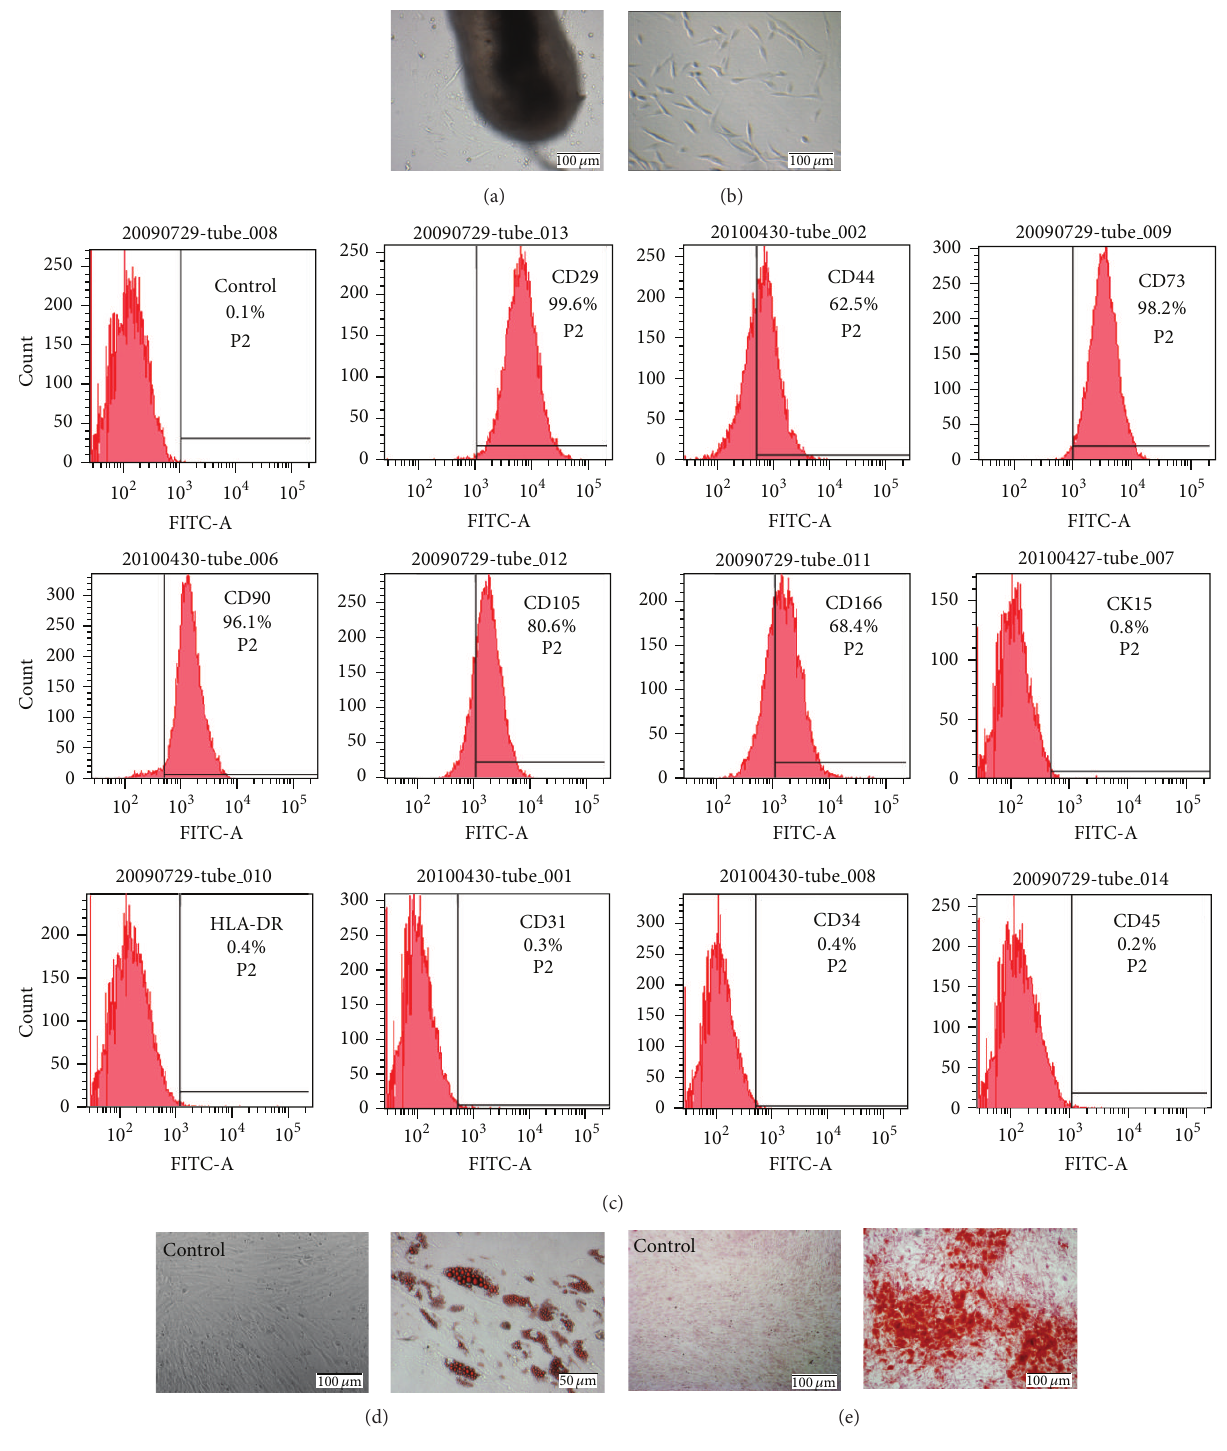
Figure 1: Isolation and characterization of hHFMSCs. (a) The hHFMSCs, resembling typical fibroblast-like cells, migrated out from the hair follicles (original magnification × 100). (b) hHFMSCs from passage 3 (original magnification × 100). (c) Flow cytometric analysis of cell surface markers on hHFMSCs. 2 × 10 5 cells were incubated with primary antibodies, followed by incubation with a secondary FITC- labeled antibody. Controls were incubated with secondary antibody only. Percentages indicate the fraction of cells that stained positive. (d) Adipogenic differentiation of hHFMSCs. Compared to noninduced control (original magnification × 100), induction after 3 weeks, the number of intracellular lipid droplets was developed and increased and was detected by Oil-red O staining (original magnification × 200). (e) Osteogenic differentiation of hHFMSCs. Calcium nodules were formed after induction for 4 weeks and were demonstrated by Alizarin red S staining (original magnification ×